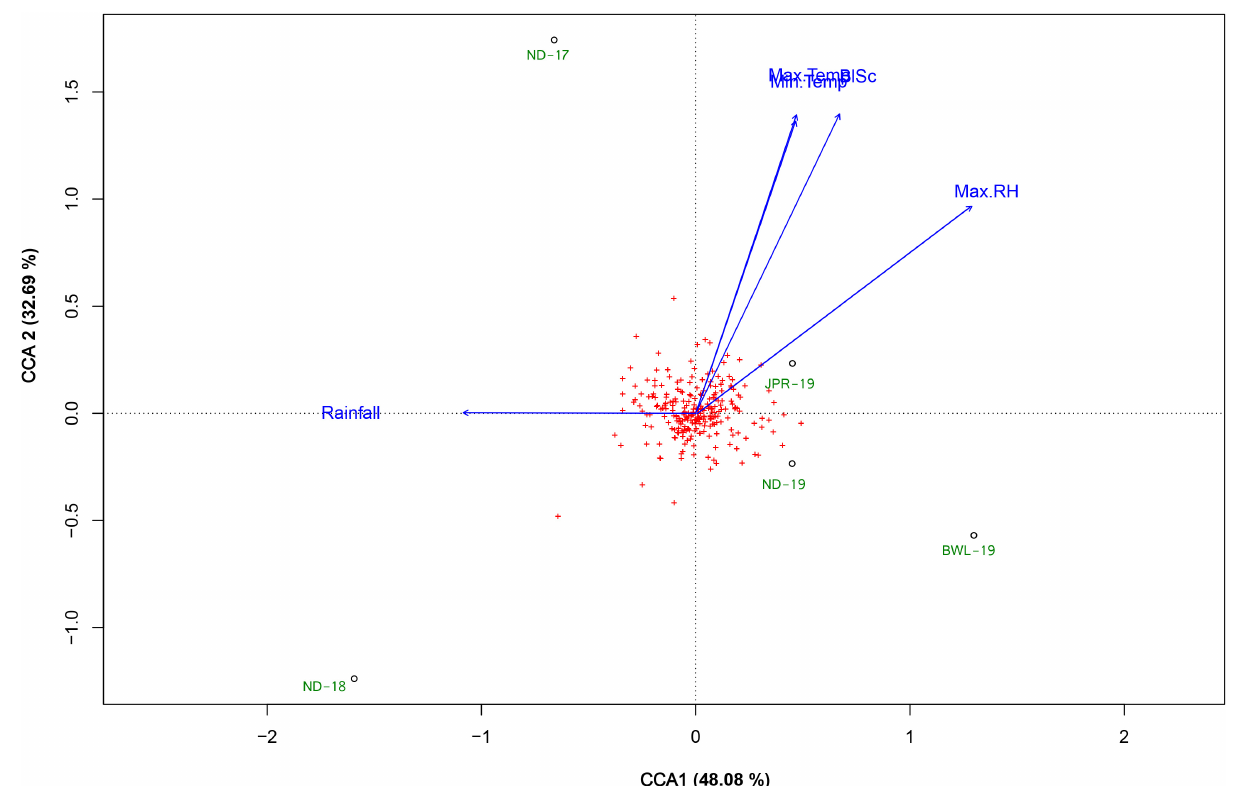
FIGURE 2 | Canonical correspondence analysis (CCA) biplot based on the correlation of several climatic parameters with foliar blast score recorded from a set of a diversity panel of 250 pearl millet accessions studied in five environments (ND-17, New Delhi-2017; ND-18, New Delhi-2018; ND-19, New Delhi-2019; BWL-19, Bawal-2019; JPR-19, Jaipur-2019). The climatic determinants were recorded during the critical crop growing period 30–60 days after sowing (DAS) period, as follows: Max. Temp, maximum temperature ( ◦ C); Min. Temp, minimum temperatures ( ◦ C); Max. RH, maximum relative humidity (%); Min. RH, minimum relative humidity (%); Rainfall, cumulative rainfall (mm); RD, cumulative number of days on which received daily rainfall > 2.5 mm; BlSc, foliar blast score.